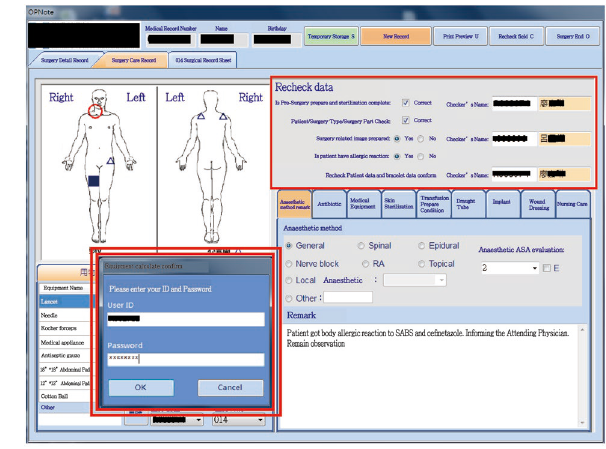
Figure 4. The surgical care records